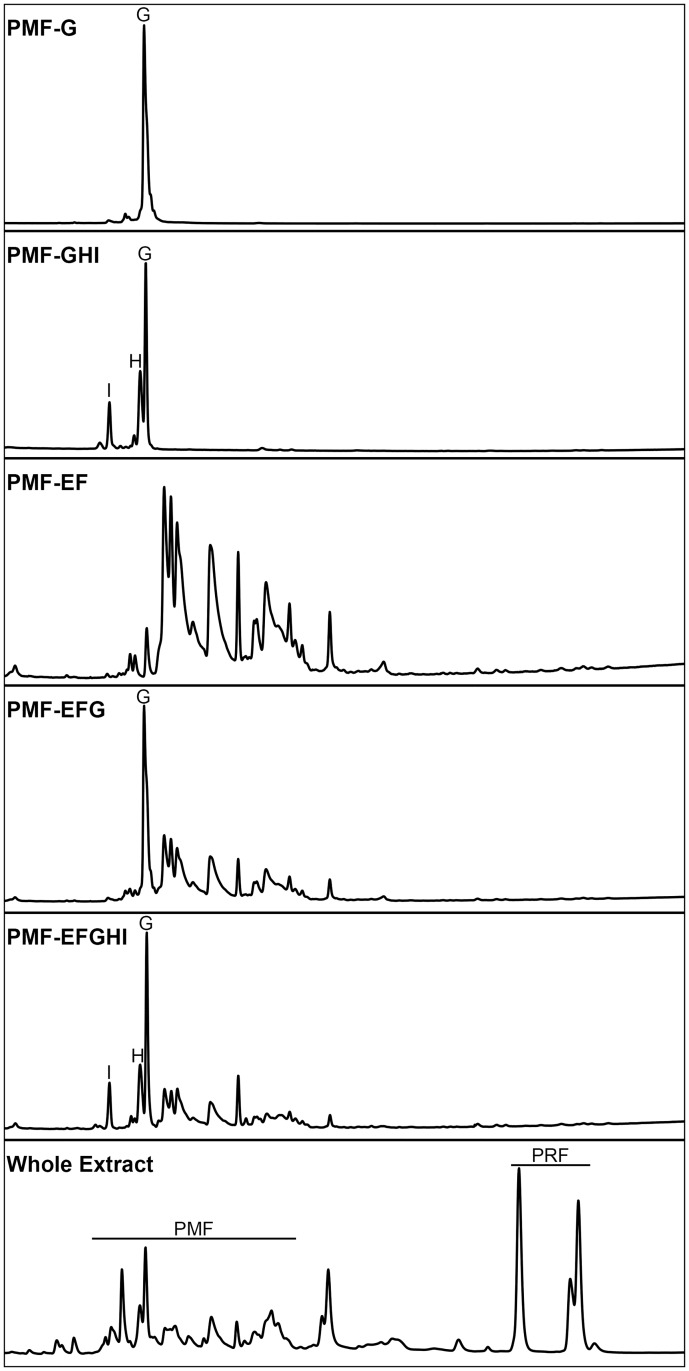
Pheromone isoform diversity.Representative reverse phase chromatograms of each tested pheromone treatment using a 0–70% acetonitrile gradient with 1% acetonitrile/min (25–60 min shown, adapted from Wilburn et al. [31]). Major PMF isoforms are denoted, as well as PMF and PRF in the whole pheromone extract.